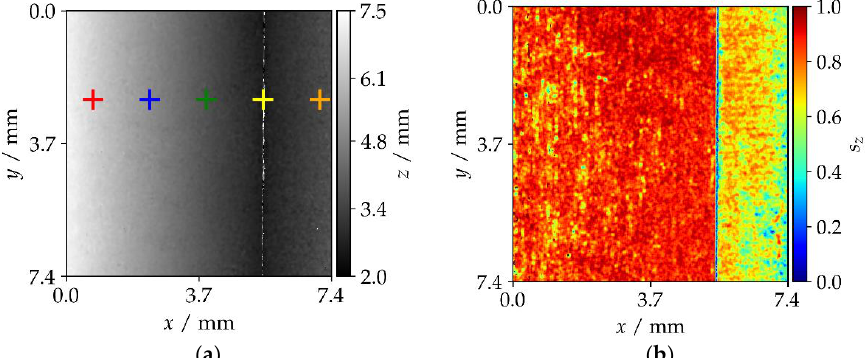
Figure 8. Shape-from-focus output including phase smoothness 𝑠 𝑧 as a quality criterion, high values show a strong result; ( a ) focus map 𝑧 𝑜𝑝𝑡,𝐺𝑎𝑢𝑠𝑠 reconstructed by pixel wise shape-from-focus Gaussian fit. The 𝑧 sections at colored crosses are illustrated in Figure 6; ( b ) optimized values of 𝑠 𝑧 using the Gaussian approach.